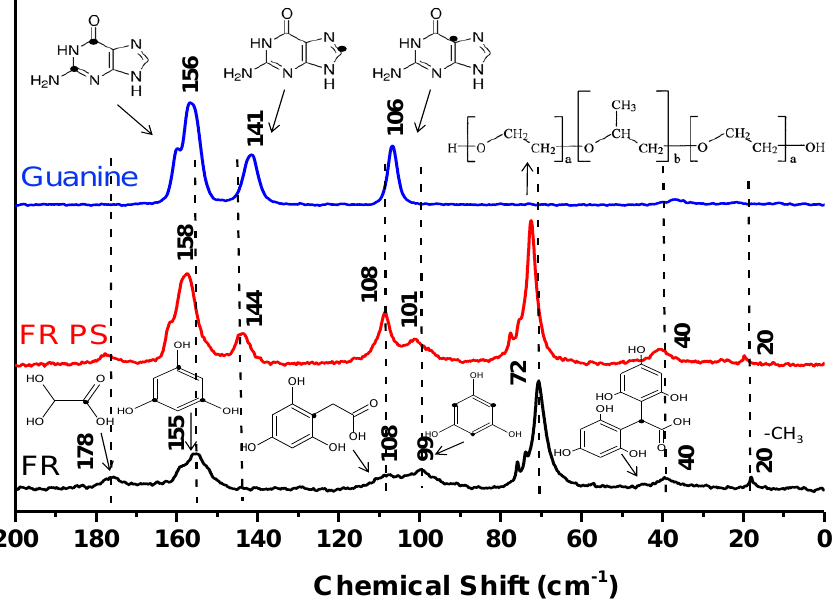
Figure 8. 13 C CPMAS NMR spectra of ( a ) guanine, ( b ) phenolic resin PS containing guanine (FR PS) and ( c ) phenolic resin (FR) prepared without guanine.